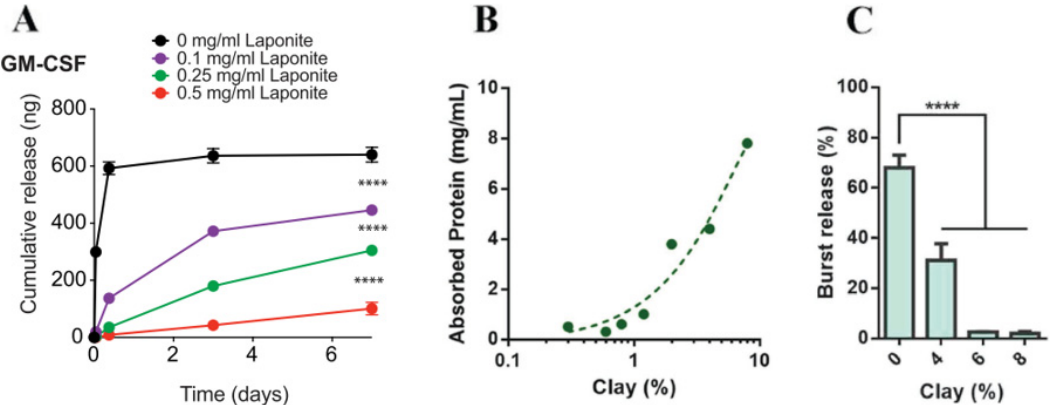
Figure 15 . ( A ) GM-CSF release from laponite-reinforced click alginate cryogels. (Adapted with permission from [72]. Copyright 2018, Elsevier). ( B ) Clay’s influence on the loading capacity of a 8 mg/mL solution of IGF1 mimetic protein and ( C ) quantification of a 24 h measured burst release from the release profiles of composite hydrogels. Adapted with permission from [74]. Copyright 2018, John Wiley and Sons).